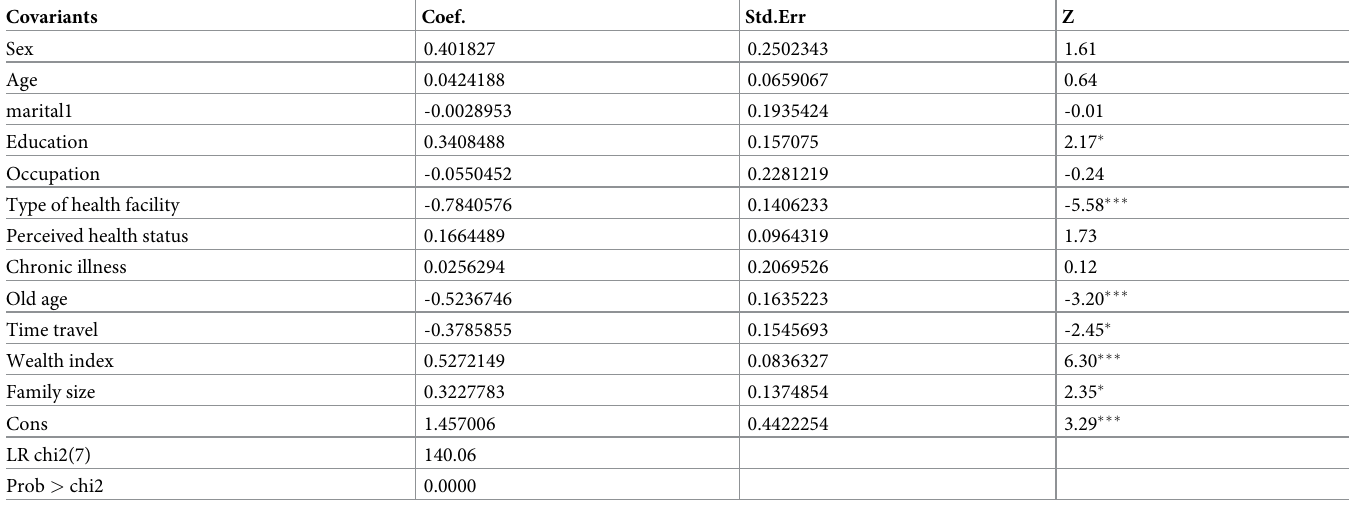
Table 5. Probit regression of participation in a community- based health insurance scheme in the Kutaber district of Ethiopia, 2020. Covariants Coef.